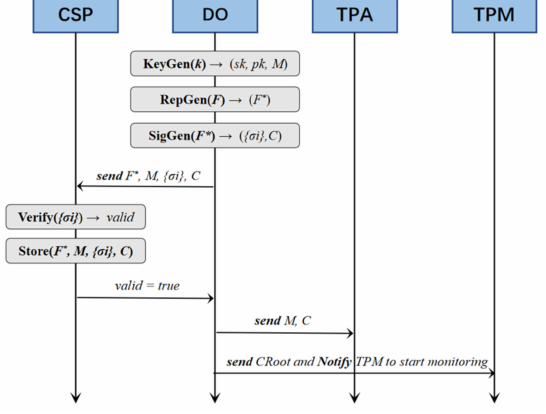
Figure 3. The parameter passing process during the initialization